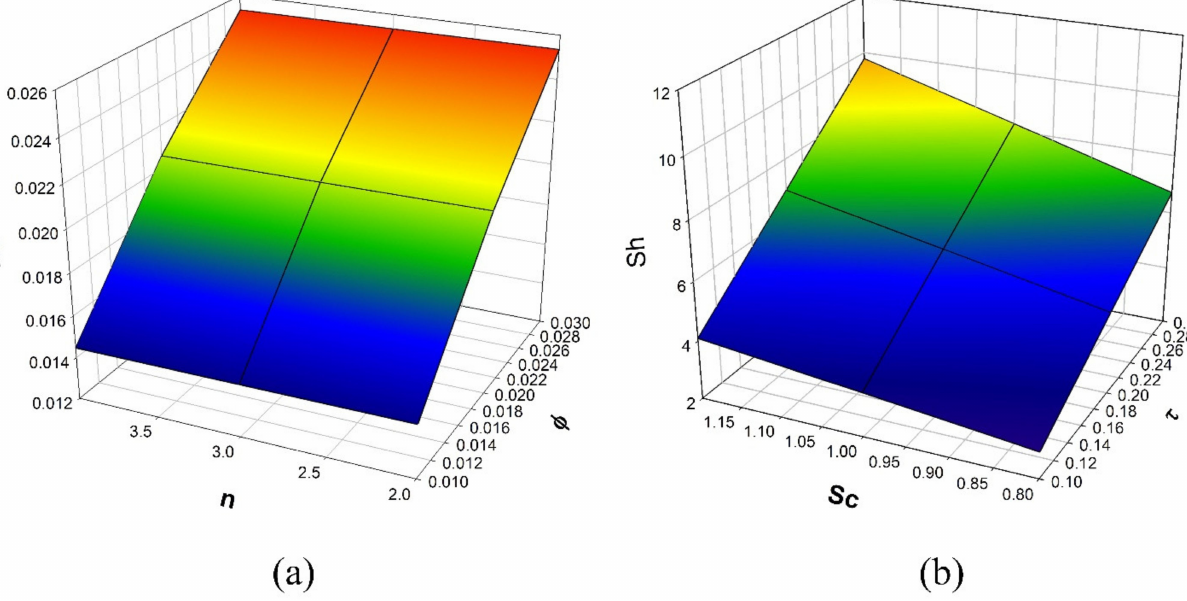
Figure 9. ( a ) Consequence of n and φ over Nu , ( b ) Consequence of Sc and τ over Sh